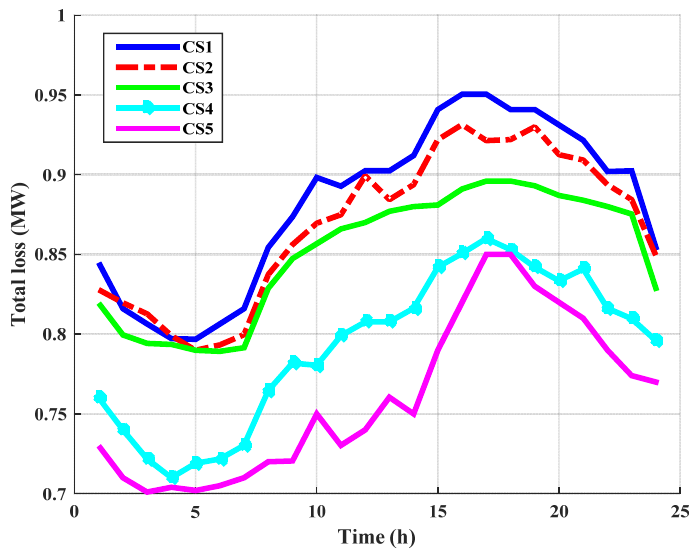
Figure 10. Active power loss of the system for different CSs over a day horizon.